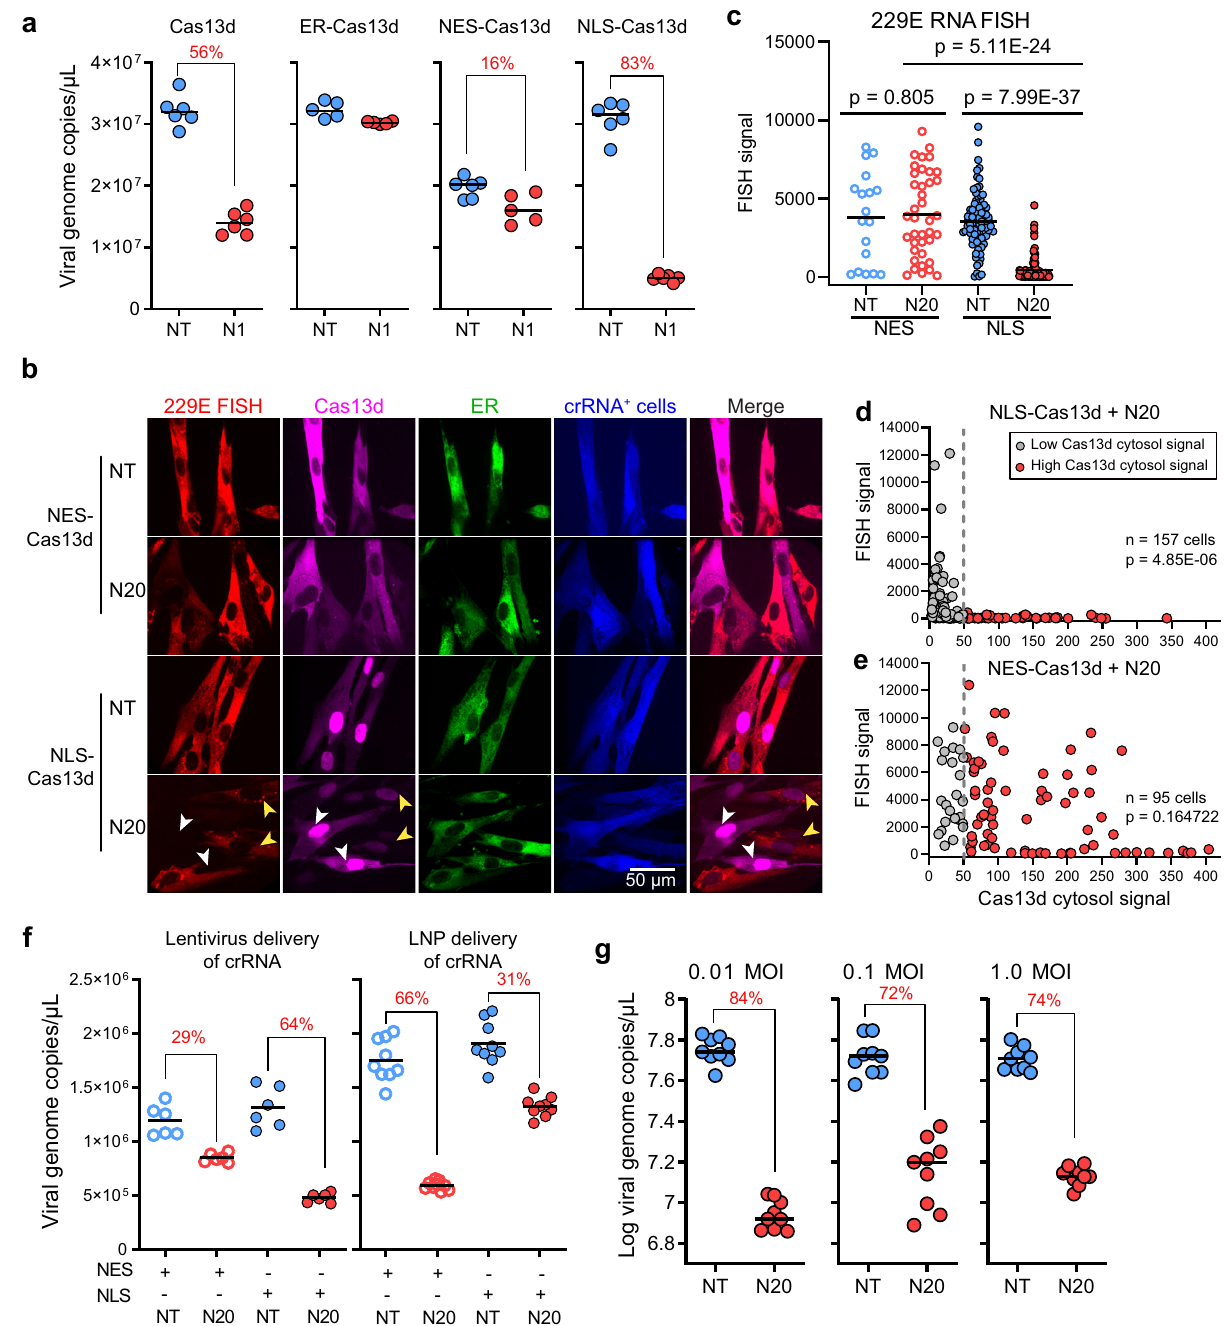
Fig. 3 Characterization and optimization of Cas13d protection against coronavirus infection. a MRC-5 cells, transduced with the indicated Cas13d (with or without a subcellular location signal tag) and the NT or N1 crRNA, were challenged with 229E. Viral titer was determined by RT-qPCR; n = 3, t = 2. b Fluorescent microscopy of MRC-5 cells expressing mCherry-fused NES or NLS-Cas13d along with the NT or N20 crRNA, infected by 229E and fi xed at 24 hpi. The 229E viral RNA was stained with RNA FISH probes labeled with AF647. c FISH signal (229E viral RNA abundance) mean intensity of each cell. All cells quanti fi ed were mCherry (Cas13d) and blue fl uorescent protein (BFP; indicates crRNA + cells) double positive. d , e The FISH signal and cytosol mCherry (Cas13d) signal measured from cells expressing NLS-Cas13d and N20 ( d ) and cells expressing NES-Cas13d and N20 ( e ). f MRC-5 cells, expressing NES or NLS-Cas13d, were delivered with indicated crRNA using lentivirus or lipid nanoparticle (LNP), and challenged with 229E. At 24 hpi, viral RNA in the supernatant was measured by RT-qPCR; n = 3 (for lentiviral delivered crRNA, t = 2; for LNP delivered crRNA, t = 3). g Cas13d antiviral activity against 229E infection at different MOIs; n = 3. n is the number of independent biological experiments. t is the number of technician repeats per biological replicate in the RT-qPCR assay. All source data in this fi gure are provided as a Source data fi le. P values are listed in supplementary Data 3, calculated by two-tailed Student ’ s t